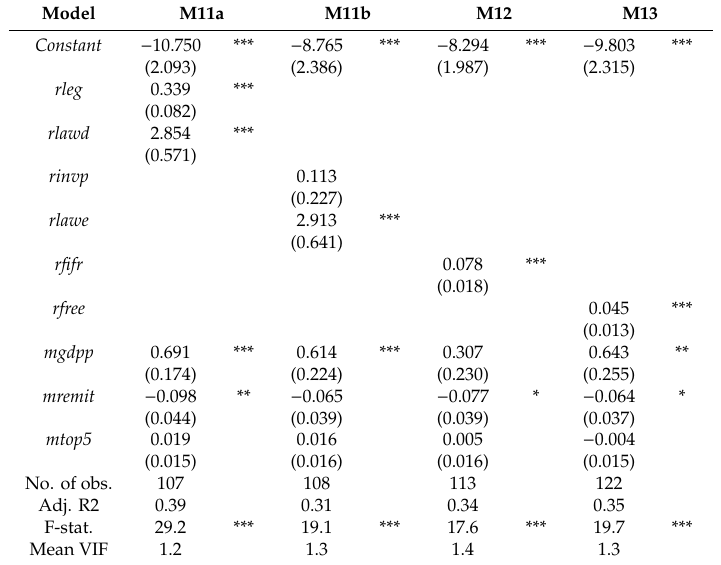
Table 3. Regulative determinants of total crowdfunding volumes during 2015–2016 per